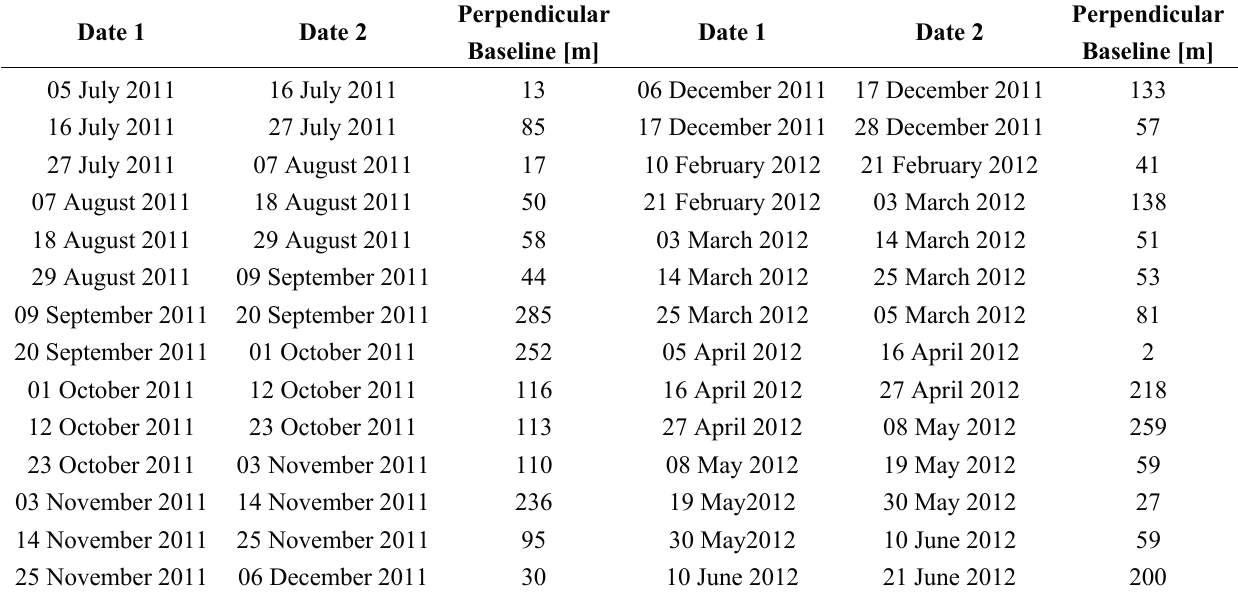
Table 2. TerraSAR-X interferograms considered in our analysis. The time interval is 11